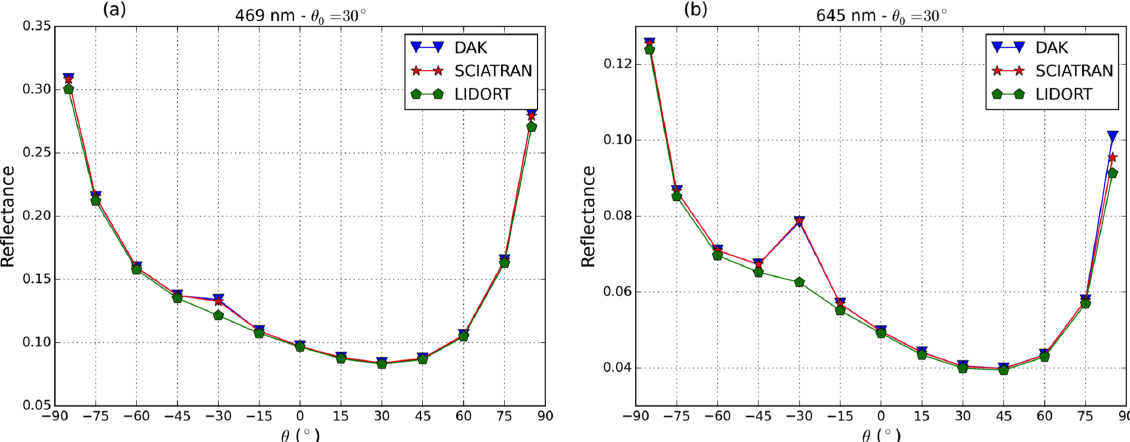
Figure 5. TOA reflectance at (a) 469nm and (b) 645nm simulated by DAK (blue), SCIATRAN (red), and LIDORT (green) with the Ross–Li surface BRDF model with parameters representing a vegetated surface over Amazonia as in Fig. 4 as a function of the viewing zenith angle in the principal plane ( ϕ − ϕ 0 = 180 ◦ for negative θ and ϕ − ϕ 0 = 0 ◦ for positive θ ), for θ 0 = 30 ◦